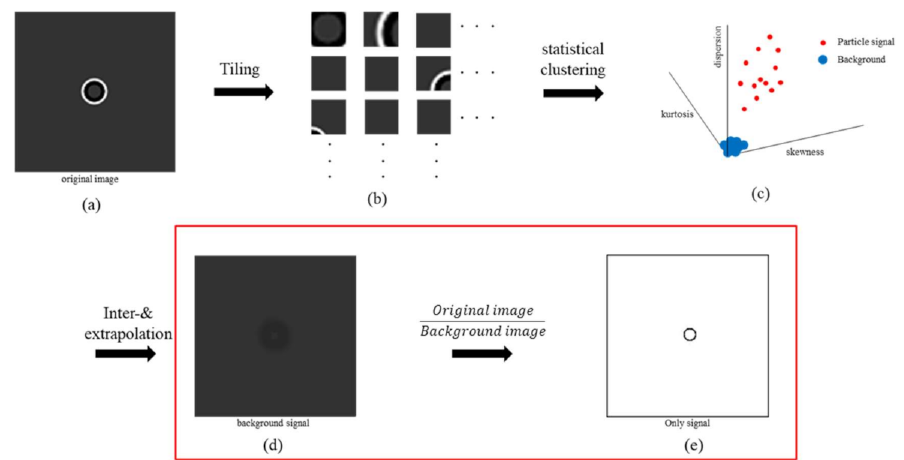
Figure 3. Background correction algorithm. ( a ) Original image, ( b ) sub-image “Tiles,” ( c ) divide two clusters using K-means clustering, ( d ) only background signal, and ( e ) divide original image into background image.